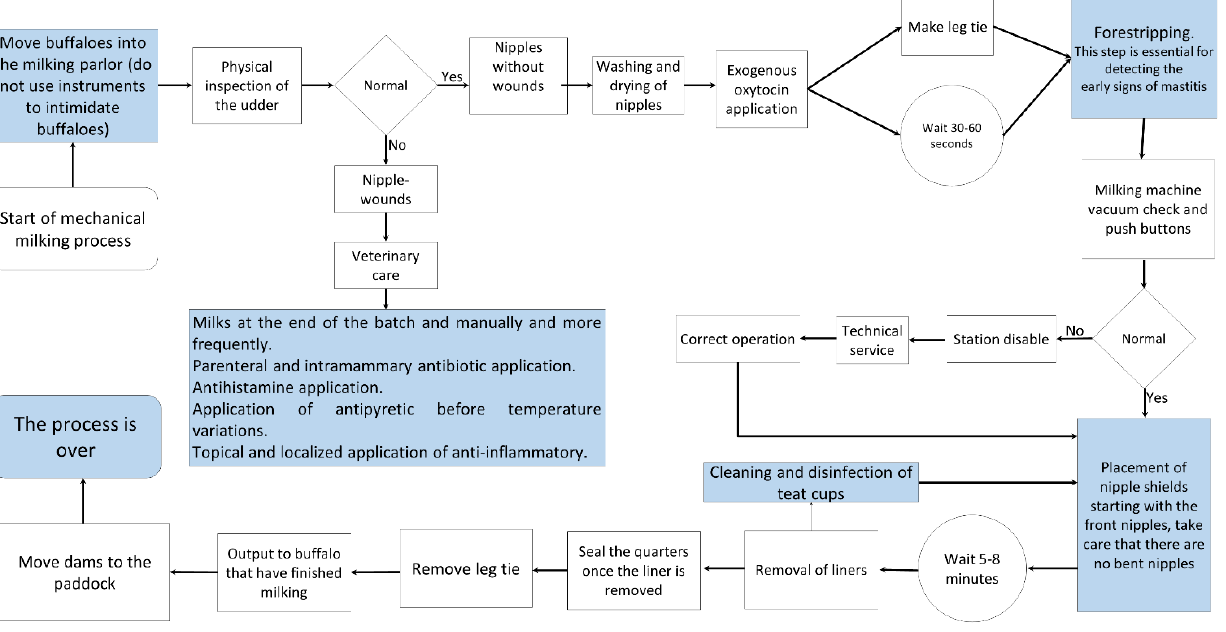
Figure 8. Flow chart of the characteristic decisions required in the manual and mechanical milking processes of water buffaloes.